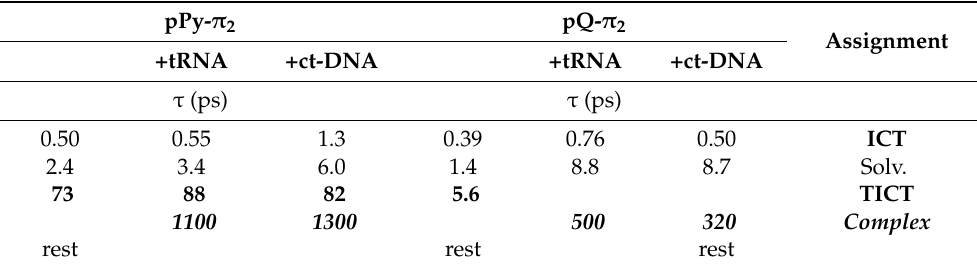
Table 4. Fs-TA results of compounds pPy- π 2 and pQ- π 2 in ETN buffer solution, pH 7.4, alone and in the presence of tRNA and ct-DNA, obtained by Global Analysis or Target